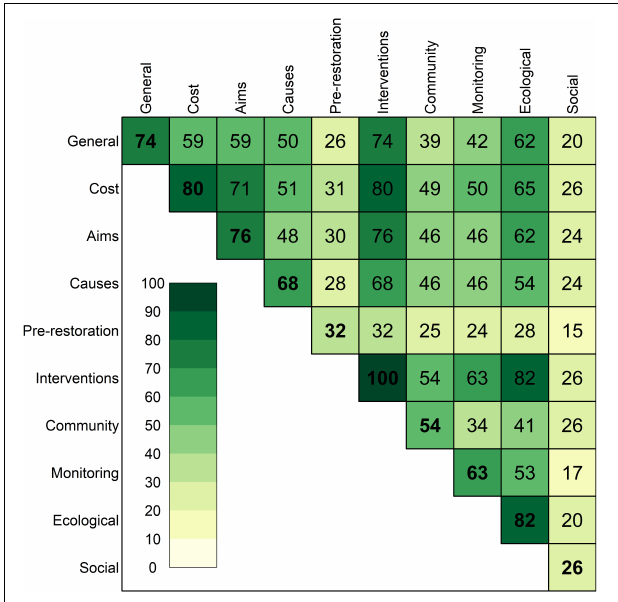
FIGURE 2 | Frequency of reporting across the different sections of our Candidate Indicator Set (CIS). A case study is considered to report on a section of the CIS if it contains any information addressing one or more indicators within the respective section, with the exception of the general section where only information for the indicators start and end dates, management status, and land tenure were used. The diagonal boxes (bold numbers) identify the percentage of case studies that record information for each single section of the CIS. The off-diagonal boxes represent the percentage of case studies that record information for the two interacting sections of the CIS.